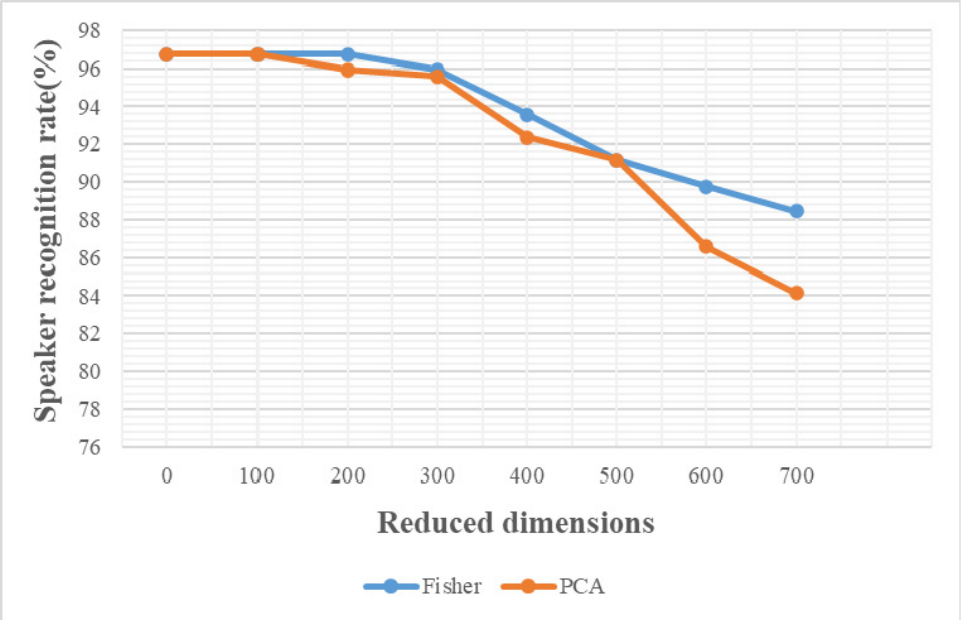
Figure 14. Speaker recognition rate of the weighted fusion feature based on two feature selection methods (20 speakers).